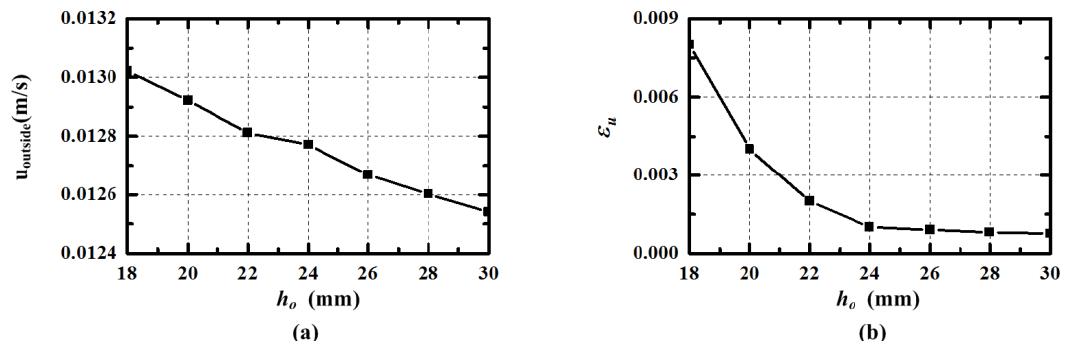
Figure 7. The velocity u outside and its error ε u in outside channel pumped by J = 25000 A/m 2 ( I = 0.66 A) varying with the central and outside channel’s height.